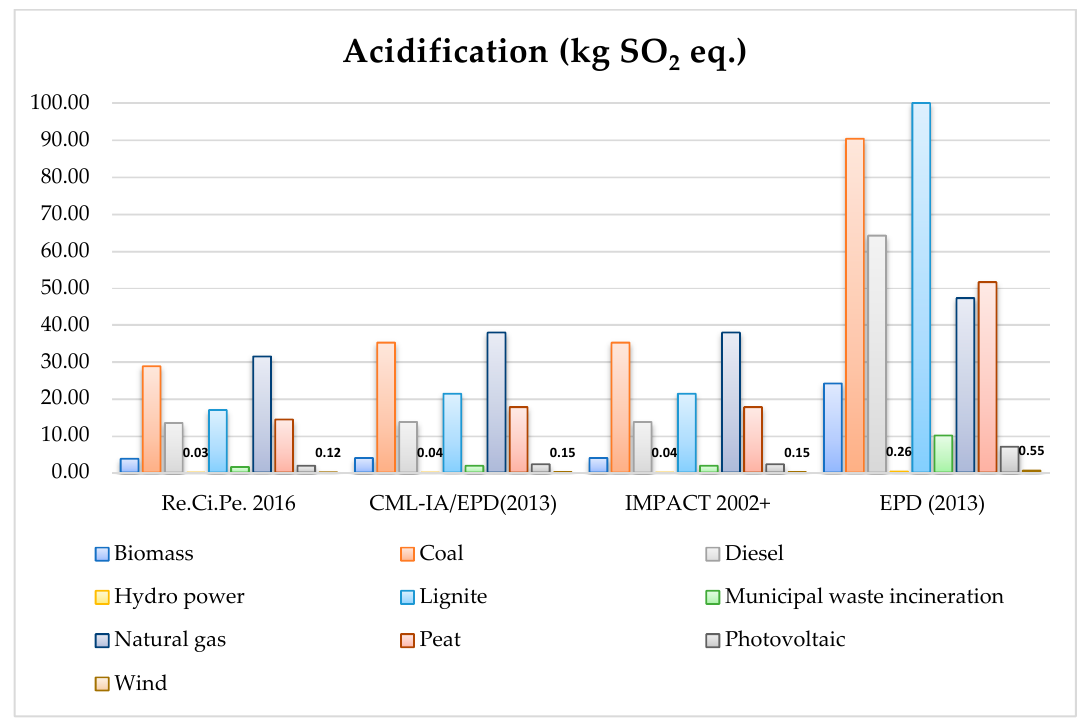
Figure 6. Comparison of acidification category using midpoint methods, expressed as a relative percentage.